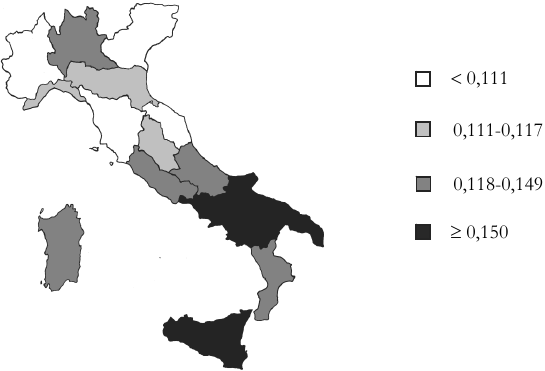
Figura 1b – Post- neonatal mortality in the Italian regions, 1881-1882.